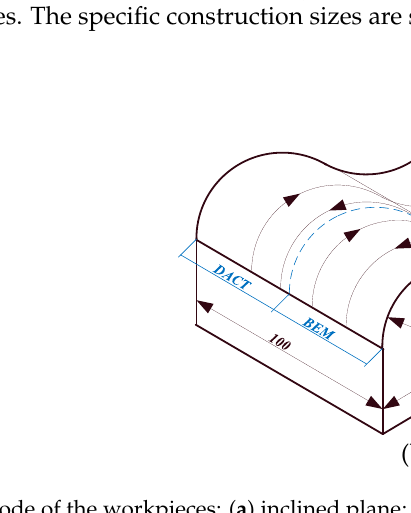
Figure 14. Tool accuracy testing equipment and accuracy testing results: ( a ) tool detection center; ( b ) Zoller operating system; ( c ) test results.